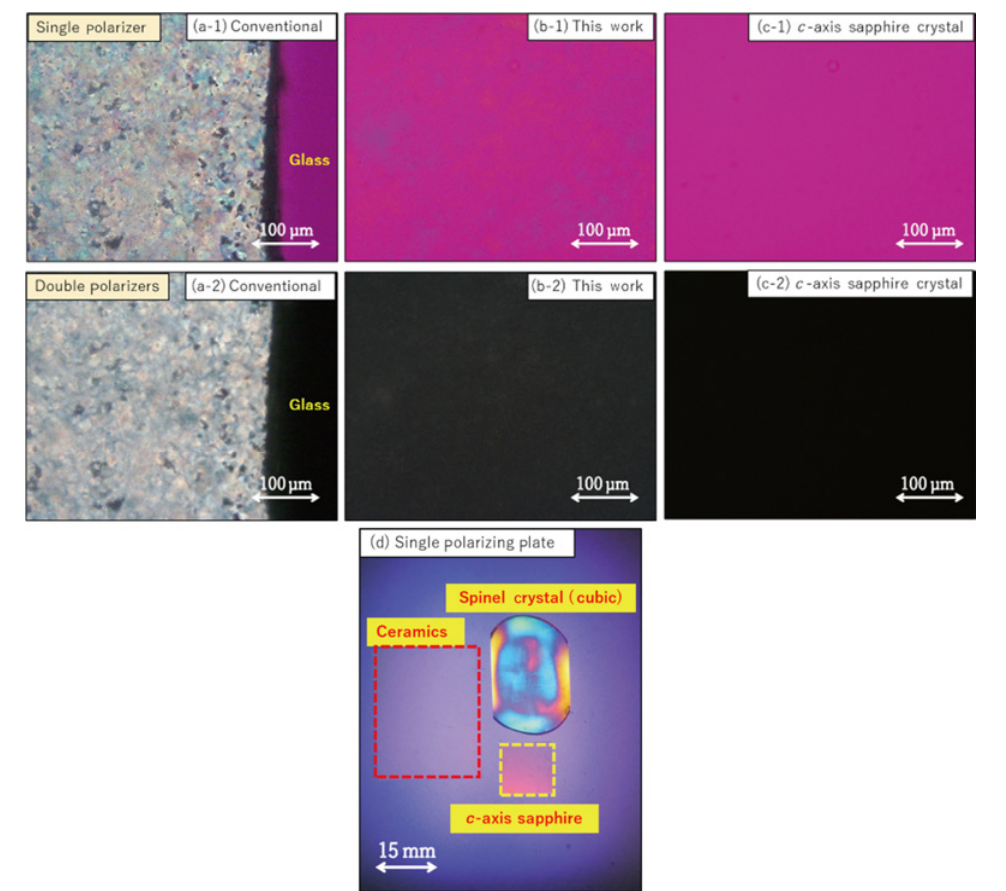
Fig. 3 Transmission polarizing images of conventional and advanced alumina ceramics and c -axis sapphire single crystals measured by (a1–c1) single and (a2–c2) double (crossed) polarizers. (d) Comparative data of birefringence distribution of c -axis sapphire single crystals, spinel single crystals, and advanced alumina ceramics placed on polarizing